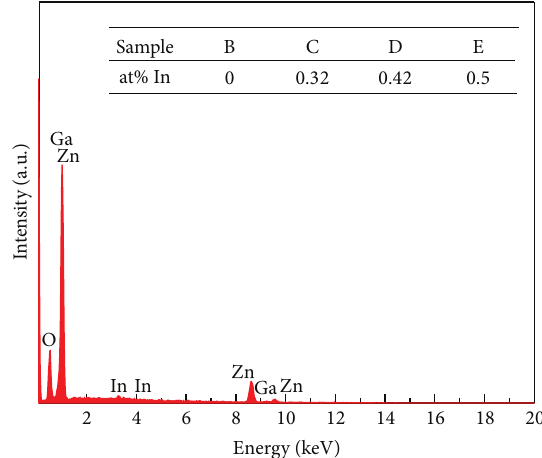
Figure 4: The EDX spectrum of postannealed C sample. The inset shows the atomic percentages of Indium element in postannealed samples from B to E calculated from EDX